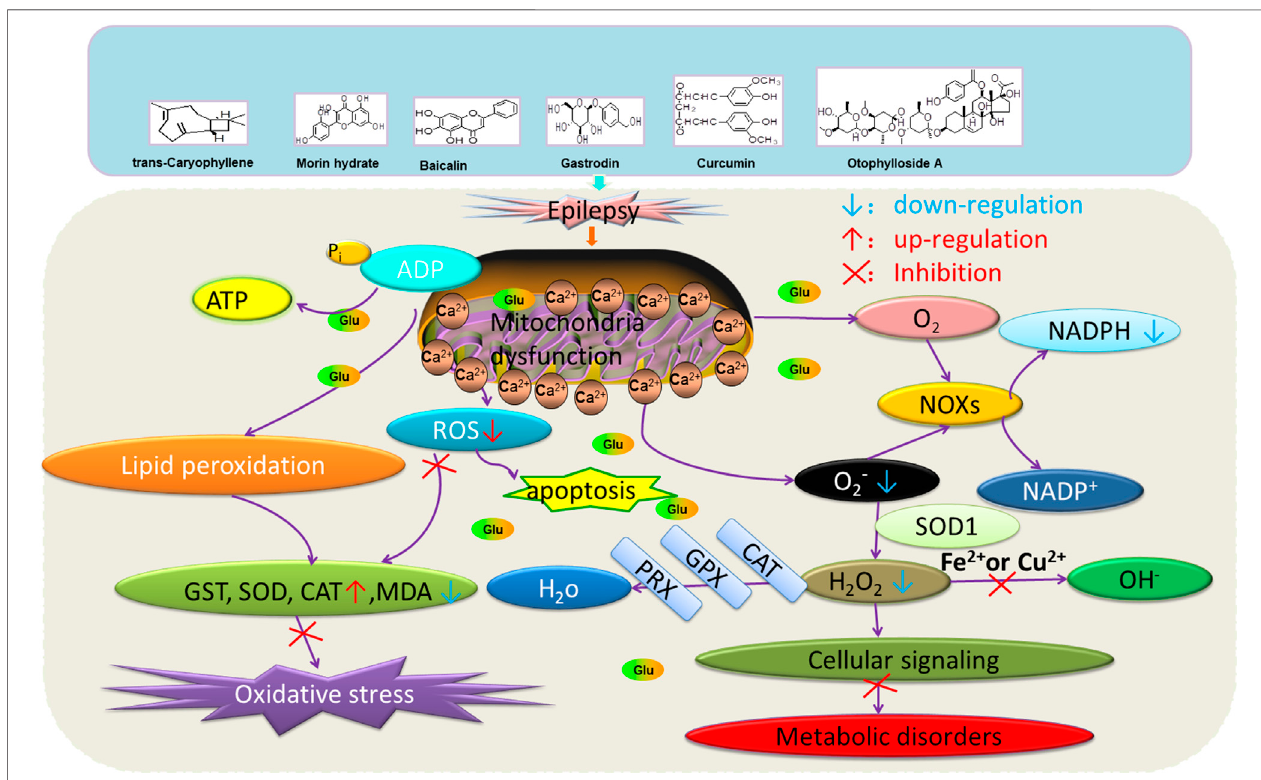
FIGURE 3 | Effects of natural drugs on mitochondrial damage and oxidative stress. Adenosine triphosphate (ATP), adenosine diphosphate (ADP), catalase (CAT), glutathione S-transferase (GST), glutathione peroxidase (GPX), peroxiredoxin (PRX), malondialdehyde (MDA), reactive oxygen species (ROS), superoxide dismutase (SOD), nicotinamide adenine dinucleotide phosphate (NADPH) oxidase (NOXs).